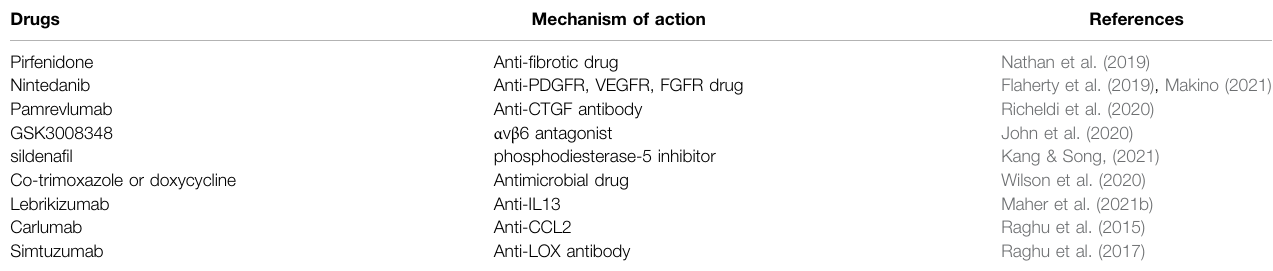
TABLE 1 | Drugs used in the treatment of Idiopathic pulmonary fi brosis